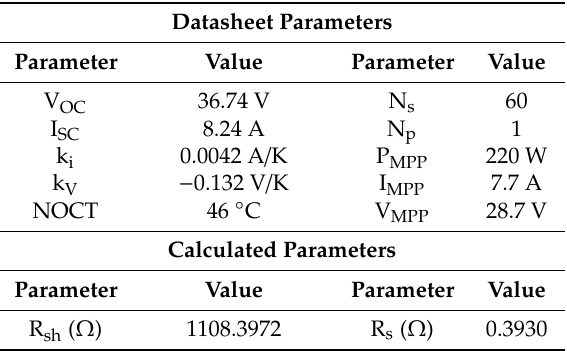
Figure 3. Schematic of System 1. Table 1. SMT6(60)P PV module